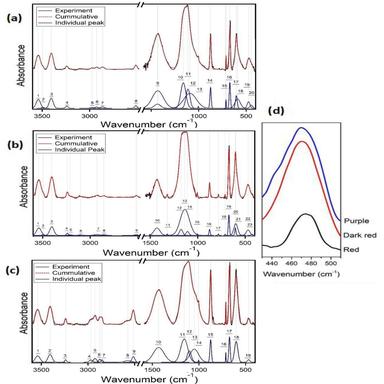
FTIR spectra of (a) purple, (b) dark red, (c) red samples, and (d) the comparison of hematite peak at a wavenumber of 475–447 cm−1.